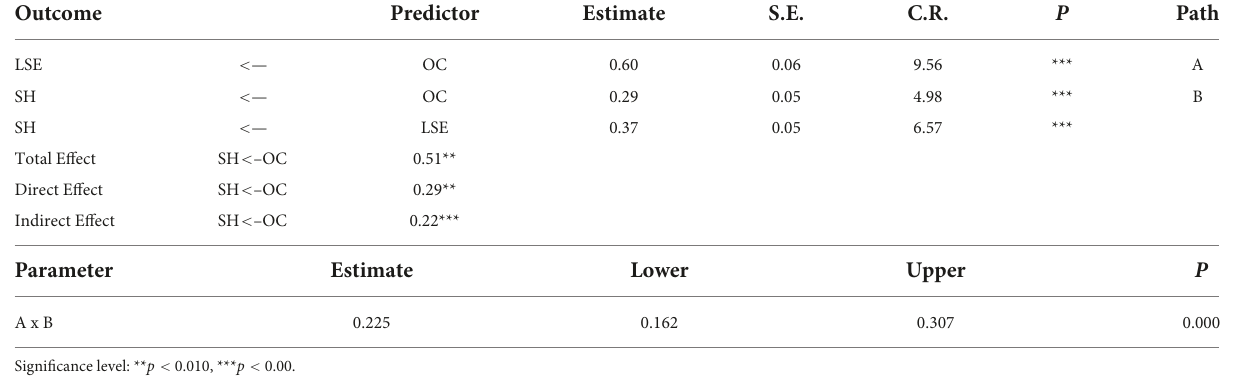
TABLE 3 Standardized regression weights.